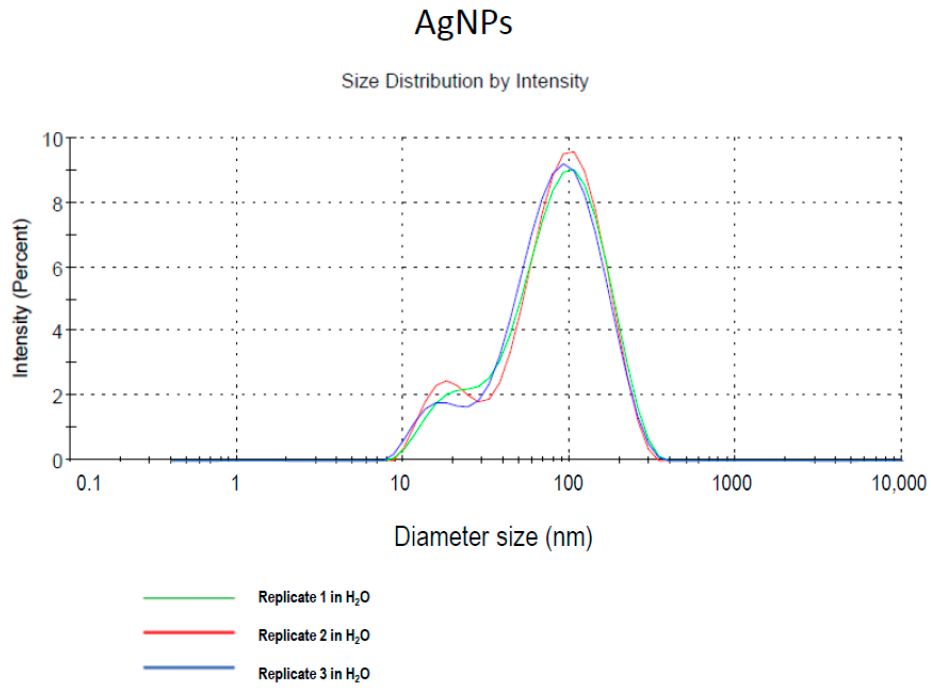
Figure 1. Size distribution determined by dynamic light scattering (DLS) measurements of model AgNPs in deionized water. Modified from Coccini et al. [27].